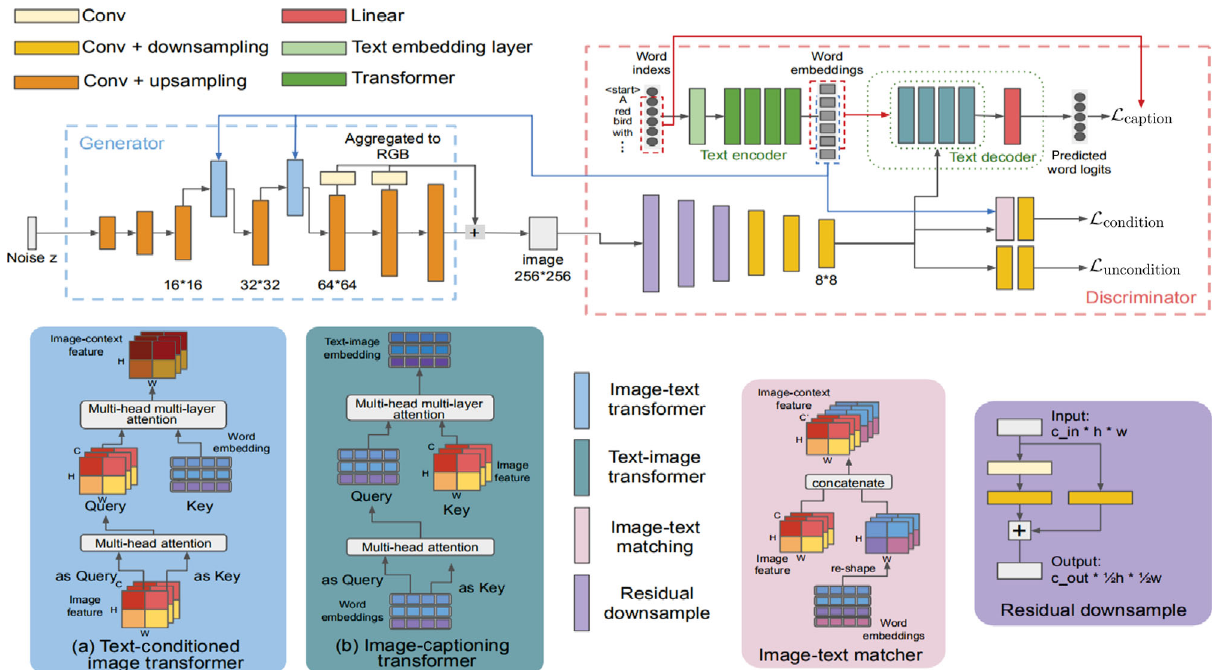
Fig. 14 TIME model overview. Reproduced with permission from Ref. [31], c (cid:2) Association for the Advancement of Artificial Intelligence